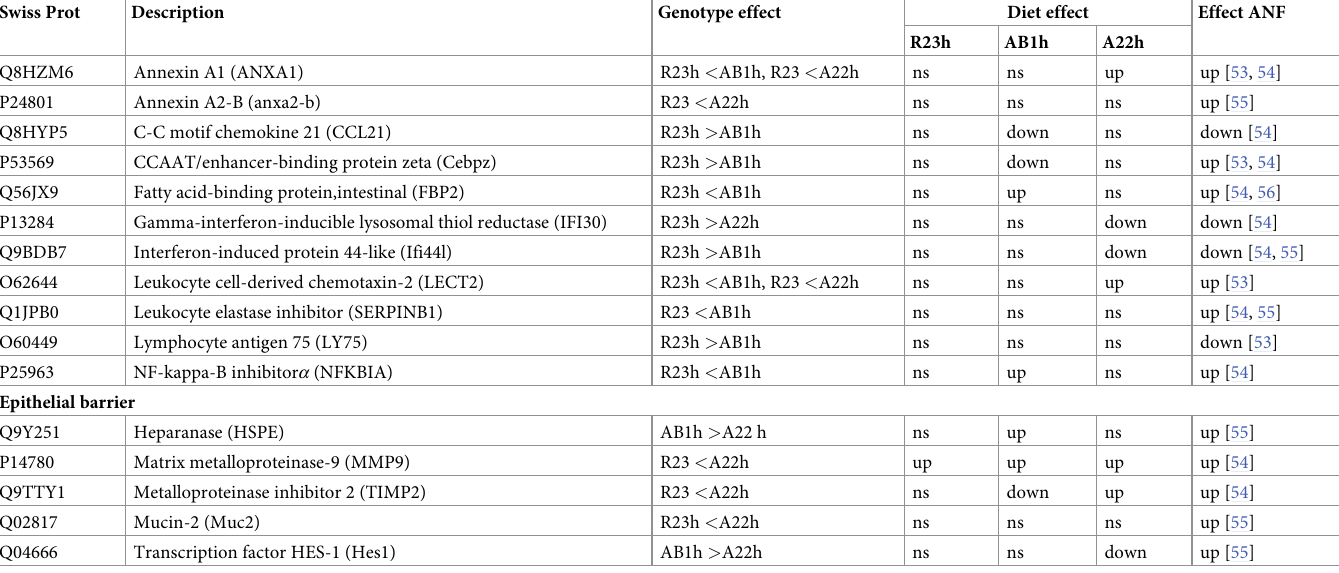
Table 7. Genes, differentially expressed between the three isogenic lines, previously identified as enteropathy markers. Swiss Prot